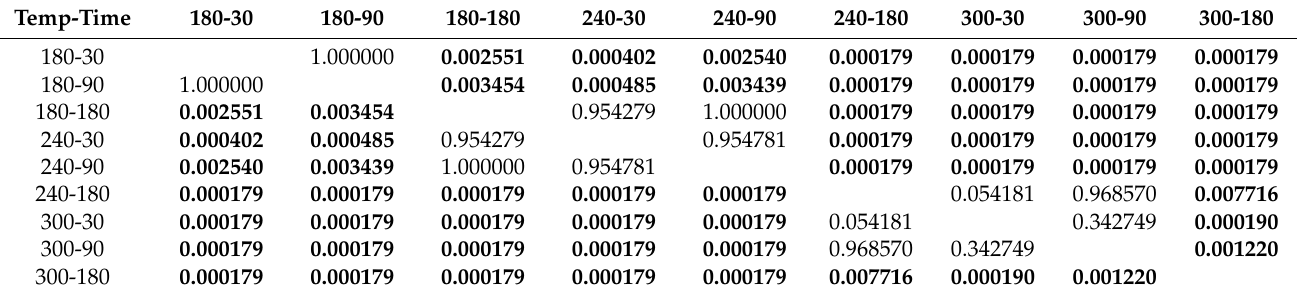
Table A1. Two-way analysis of variance (ANOVA) with post hoc Tukey test for FC content, a bold font signifies a statistically significant difference ( p < 0.05).